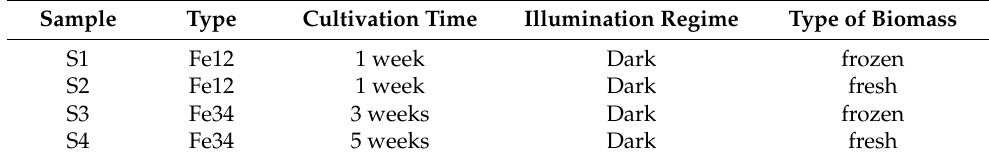
Table 1. Experimental conditions for the synthesis of biogenic ferrihydrite nanoparticles. Sample Type Cultivation Time Illumination Regime Type of Biomass S1 Fe12 1 week Dark frozen S2 Fe12 1 week Dark fresh S3 Fe34 3 weeks Dark frozen S4 Fe34 5 weeks Dark